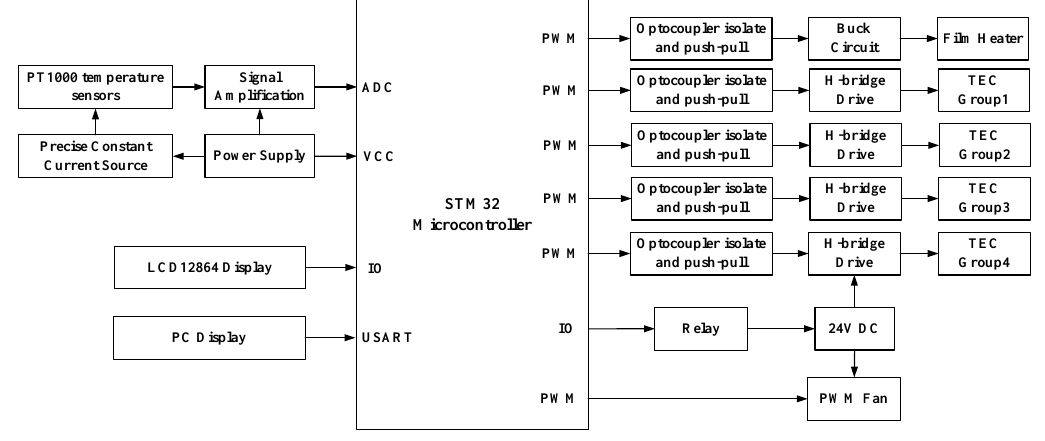
Figure 6. Diagram of the hardware circuit.